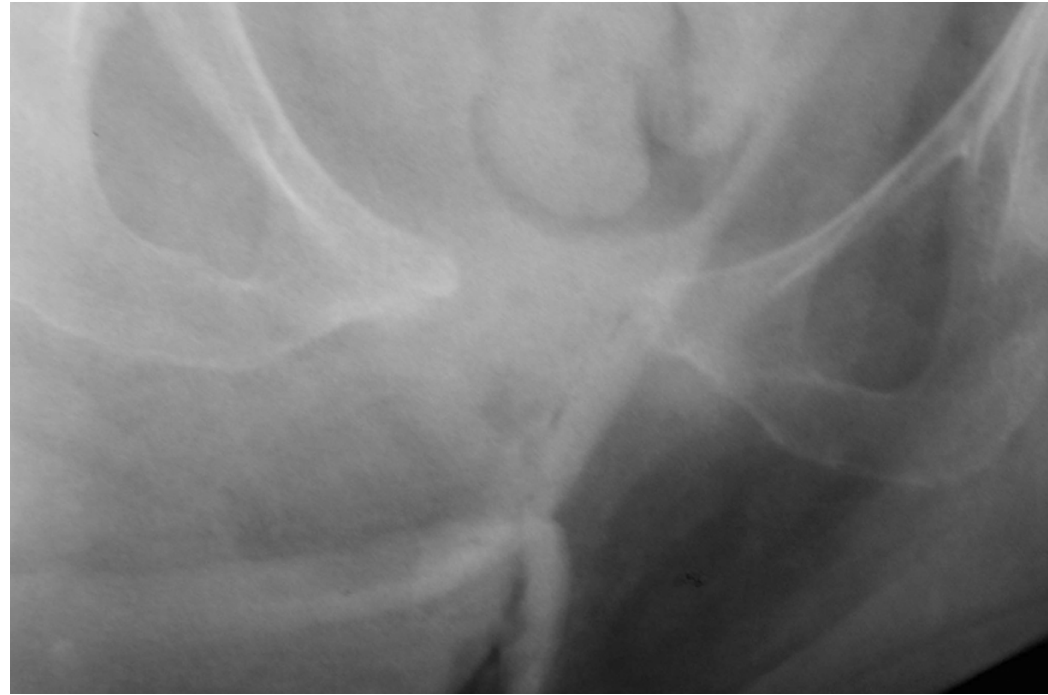
FIGURE 1. X-ray of pelvis, taken on 20 April 2000, shows no radio-opaque calculus in urinary bladder. Presence of diastasis of symphysis pubis with a wide gap between the pubic bones is confirmed.